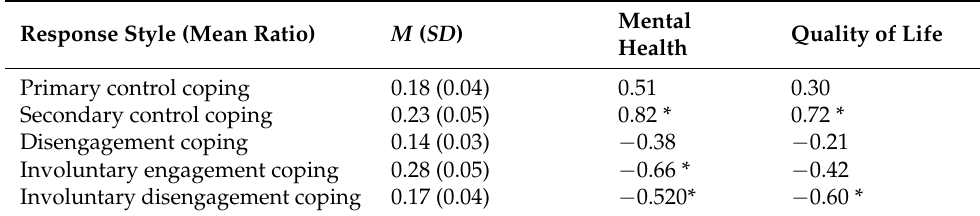
Table 2. Response style by parents measured using the Relationship Stress Questionnaire and its relationship to mental health and quality of